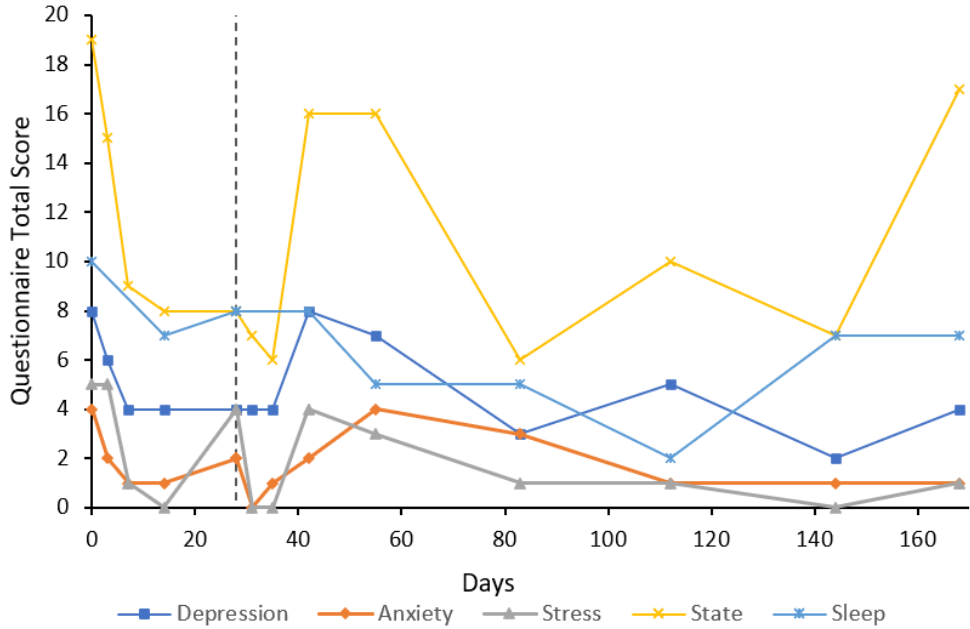
Figure 3. Line graph showing Case 3 results from the DASS-21 (depression, anxiety, and stress subscales), SSAI-6, and JSS at each follow-up. The participant was treated with an eight-day flumazenil infusion and re-treated on day 28 with a four-day flumazenil infusion (denoted by a dashed